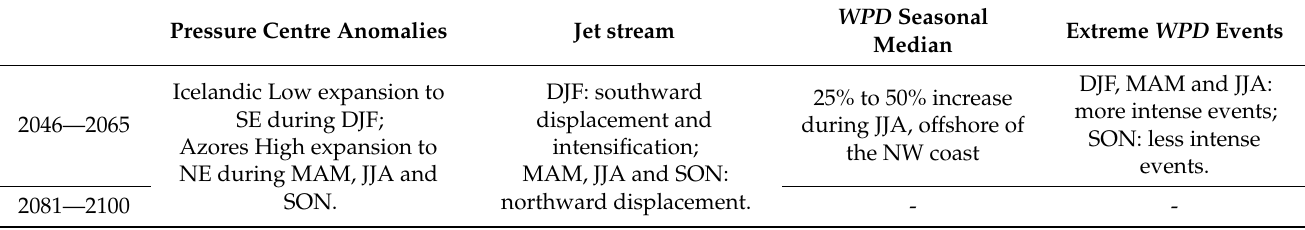
Table 3. Summary of the